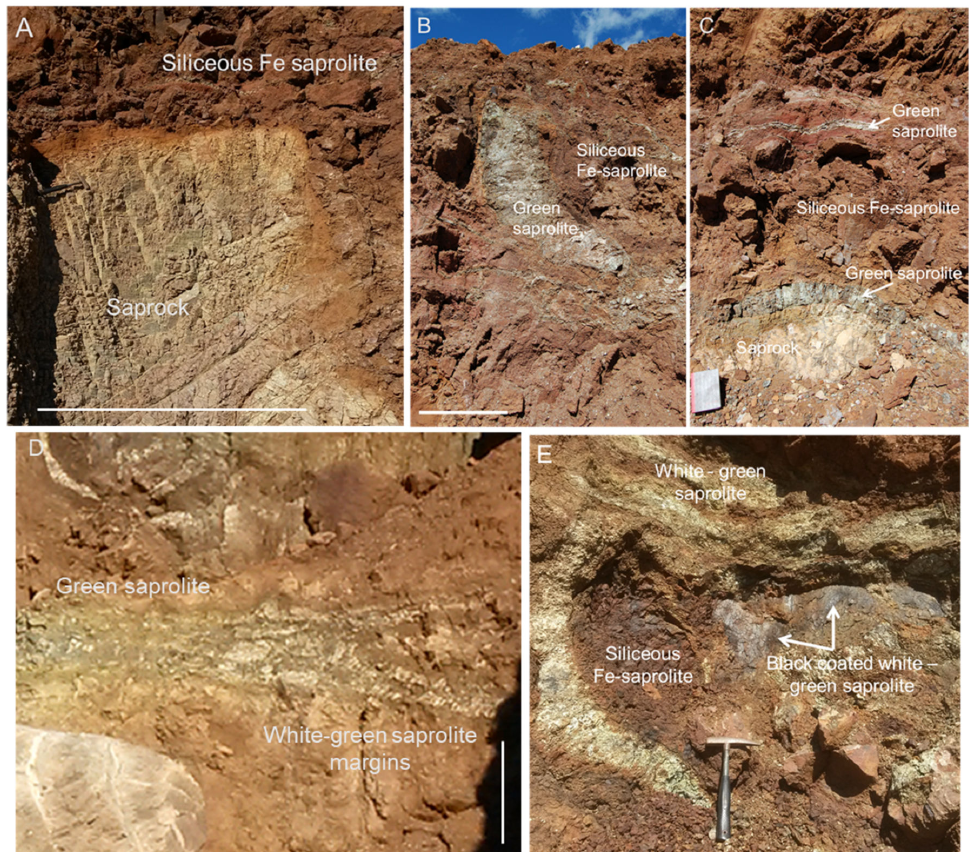
Figure 3. Details from the rock units observed in the profile of the Piau í deposit ( A ) Contact between the saprock and the overlying siliceous saprolite. Scale bar is 1.5 m. ( B , C ) Examples of the green saprolite components within the siliceous Fe-saprolite. Scale bar on B is 1 m. ( D ) Green saprolite layer with white-green margins. Scale bar is 1 m. ( E ) Thick desiccating black coating on kaolinite rich white-green